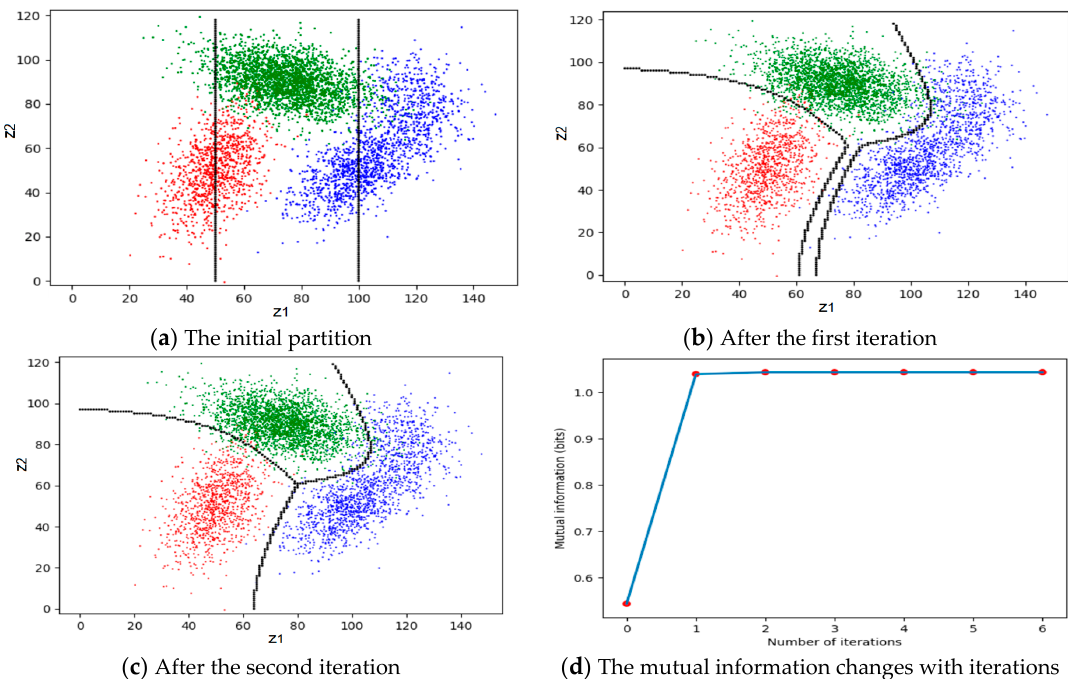
Figure 11. The Maximum Mutual Information (MMI) classification of unseen instances. The classifier is y = f ( z ). The mutual information is I ( X; Y ). X is a true class and Y is a selected label. After two iterations, the mutual information I ( X ; Y ) was 1.0434 bits. The convergent MMI was 1.0435 bits. Only two iterations were required for the mutual information to reach 99.99% of the convergent MMI.